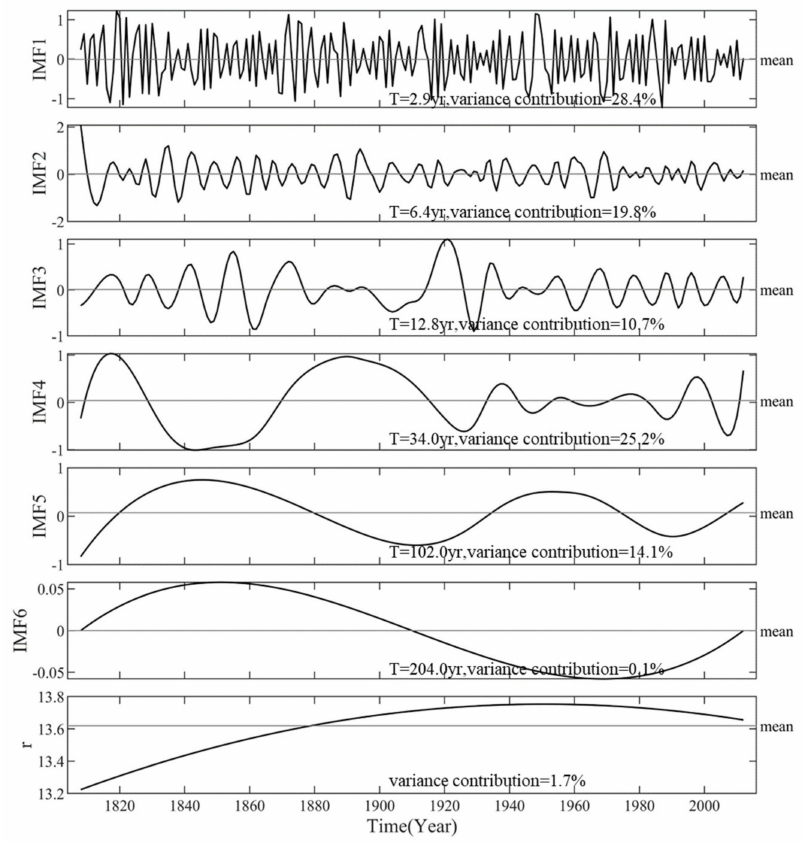
Figure 6. Results of the EEMD of VP JA reconstruction. The periodicities and variance contributions are demonstrated. IMF represents intrinsic mode function.